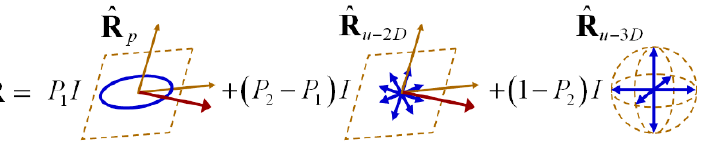
R and the 3D unpolarized state has pO ( P = P < 1 ) [20]. 2 d